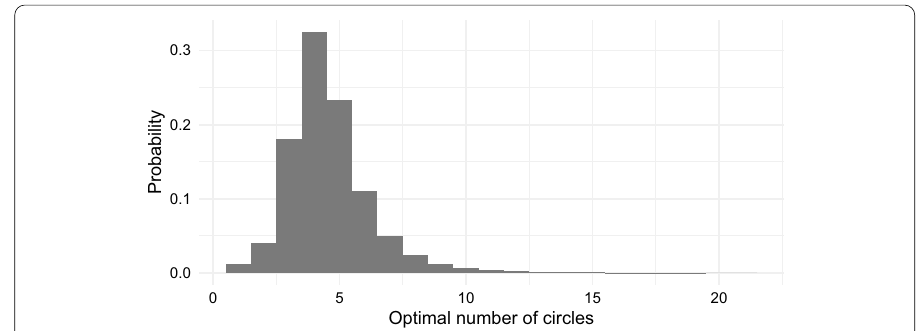
Fig. 8 Distribution of the optimal number of collaboration circles